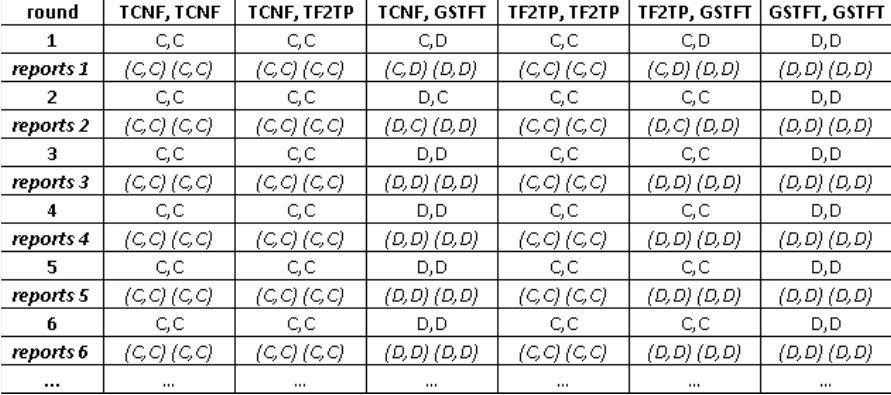
Patterns of interactions and reports for every possible pair of strategies in an exemplary population consisting of CNFT, TF2TP and